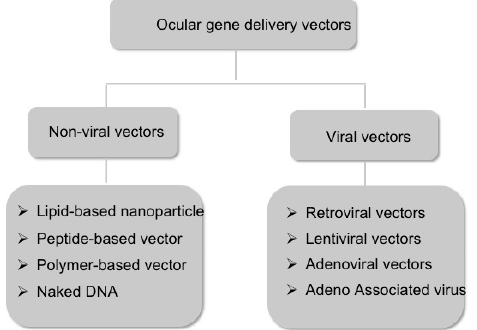
Figure 2. Schematic representation of the major subtypes of the ocular gene delivery vectors.